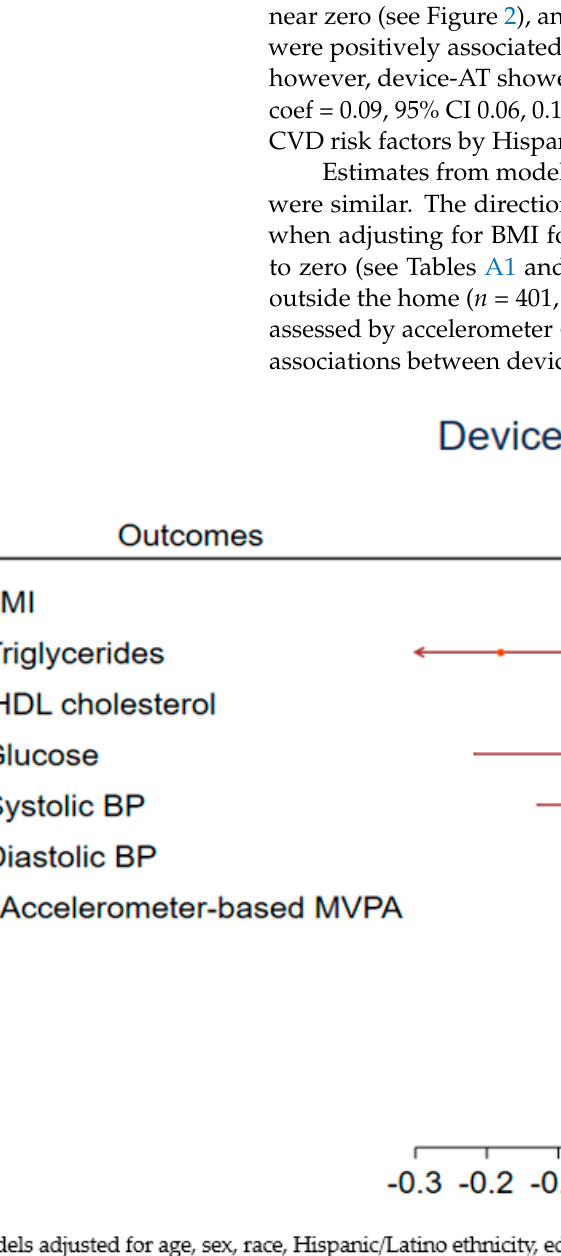
Figure 1. Adjusted associations between device-measured AT (min/day) and CVD risk factors.